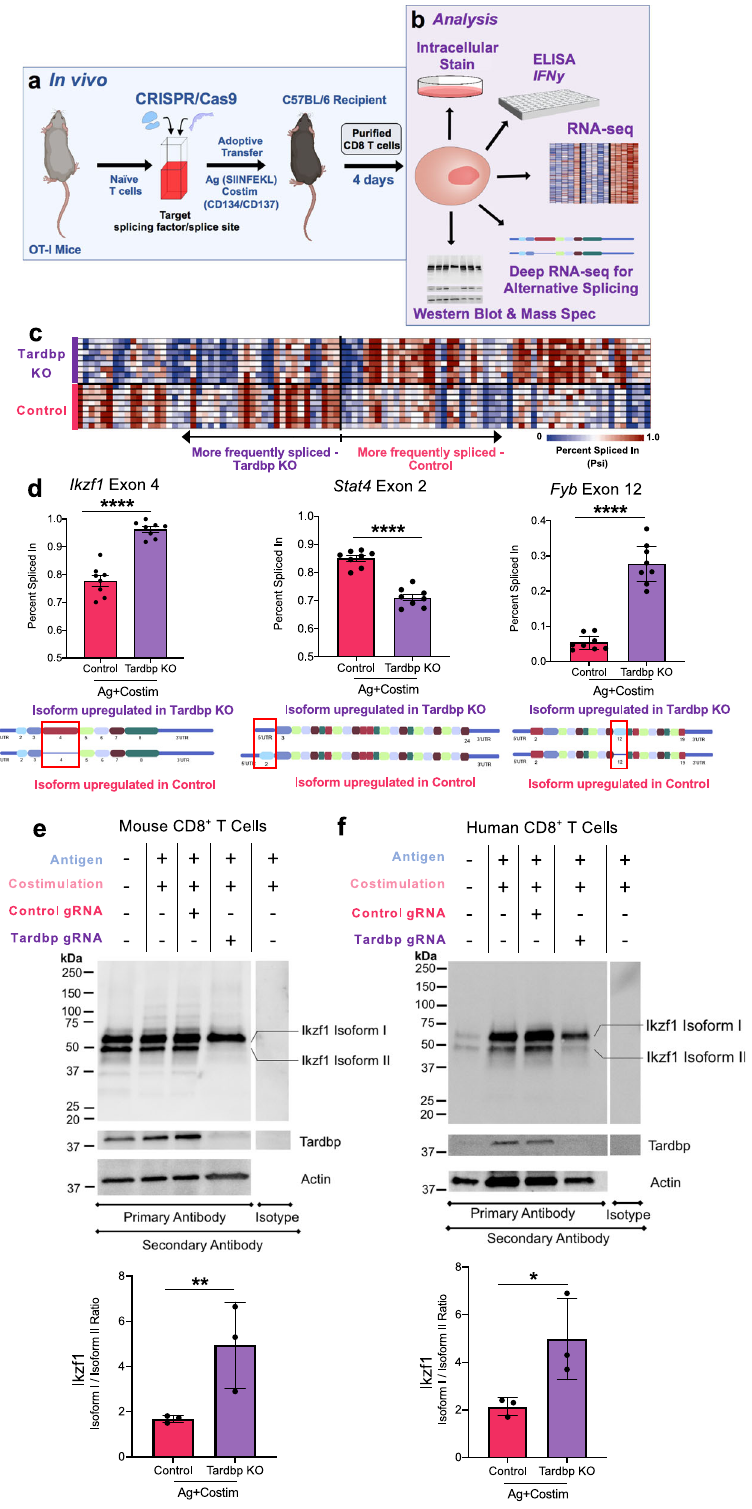
(out of the 26 initially identi fi ed), found in T cell costimulation pathways, and observed in Tardbp CLIP-seq data seen in Fig. 3 (Figs. 3, 5b and Supplementary Data 5, highlighted). In addi- tion, we found that APA changes to the 3 ′ UTR in the genes Ikzf1 , Mbnl1 , and Tcf12 were identi fi ed in two separate analysis of APA using Whippet and DaPars (Fig. 5b). Importantly, these data showed that knockout of Tardbp in costimulated CD8 +